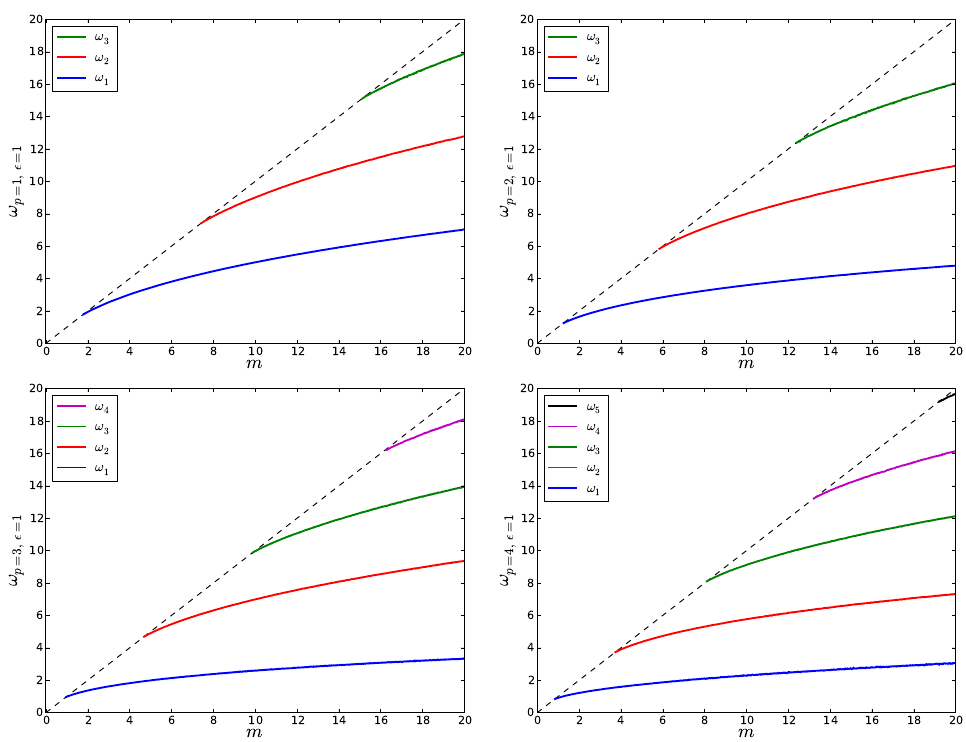
Figure 12 . The lowest oscillating modes for the L 2460 Skyrme model ( (cid:15) = 1) with the Lin-Piette ( p ) , p = 1 ; 2 ; 3 ; 4, as a function of the pion mass m . potentials U